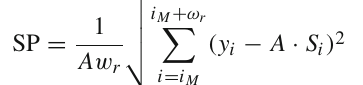
combined efficiency has a constant value of ε C = (95.7 ± 0.5) % above 150